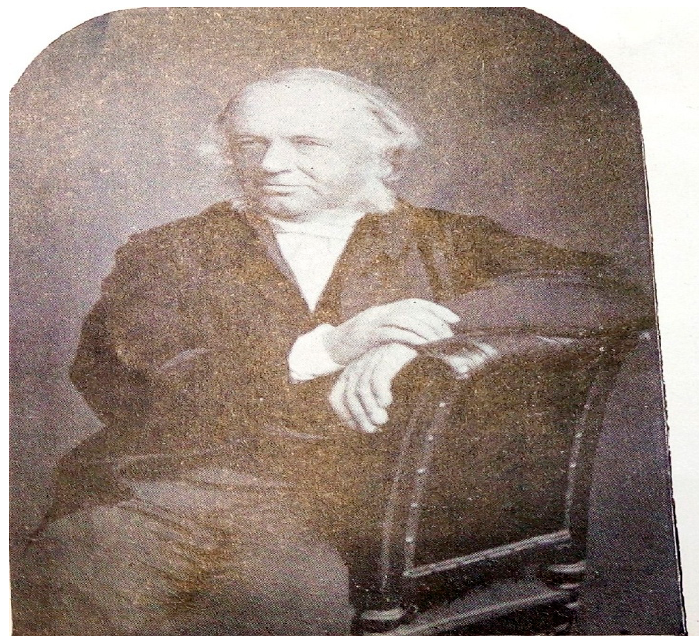
Figure 3. Missionary Edward Porter (Source: (Simmons 1923, p. 8)).